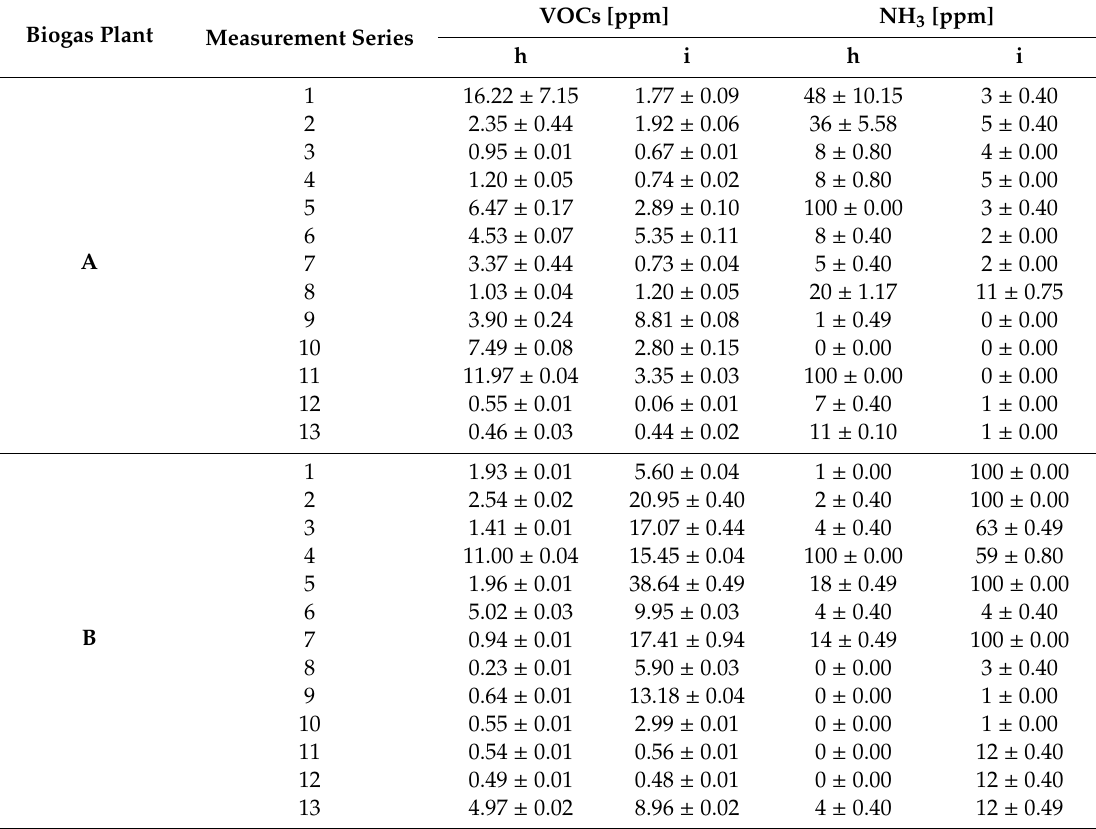
Table 6. Measurement results for the oxygen stabilization technological operation. Biogas